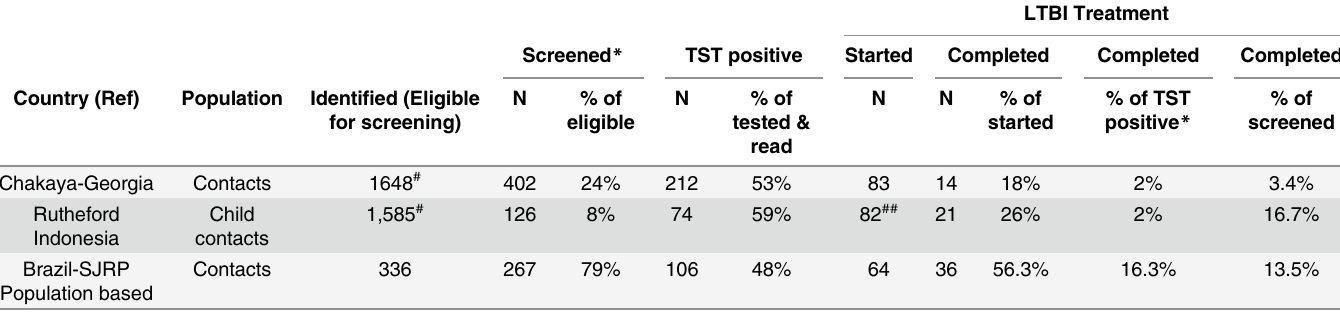
Table 1. Dropouts and losses during follow up in different stages of LTBI diagnosis and treatment Cascade of